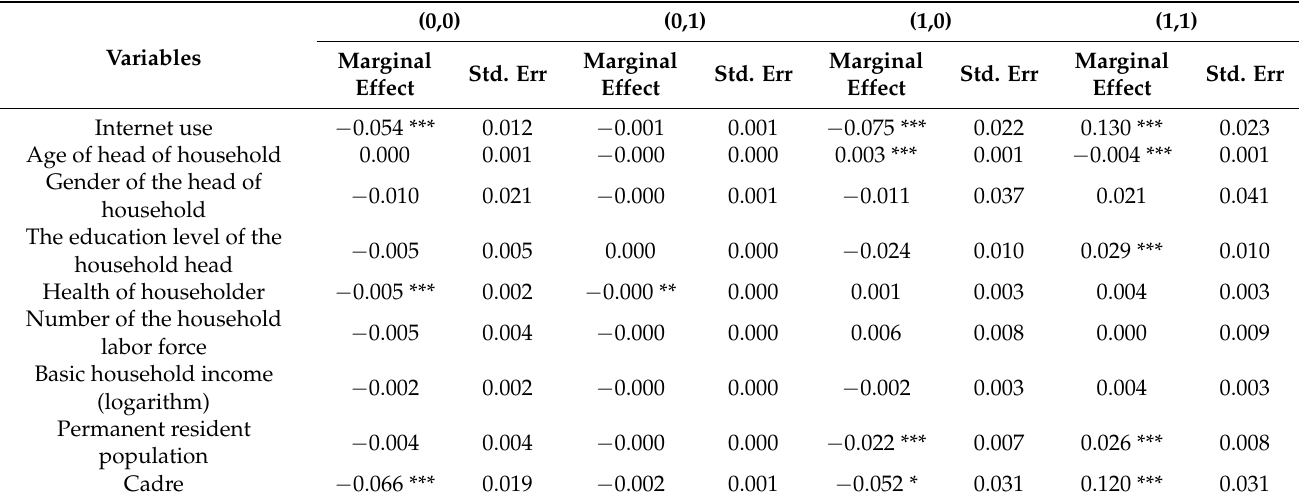
Table 3. Analysis the results of the deviation of willingness and behavior in relation to farmers’ garbage